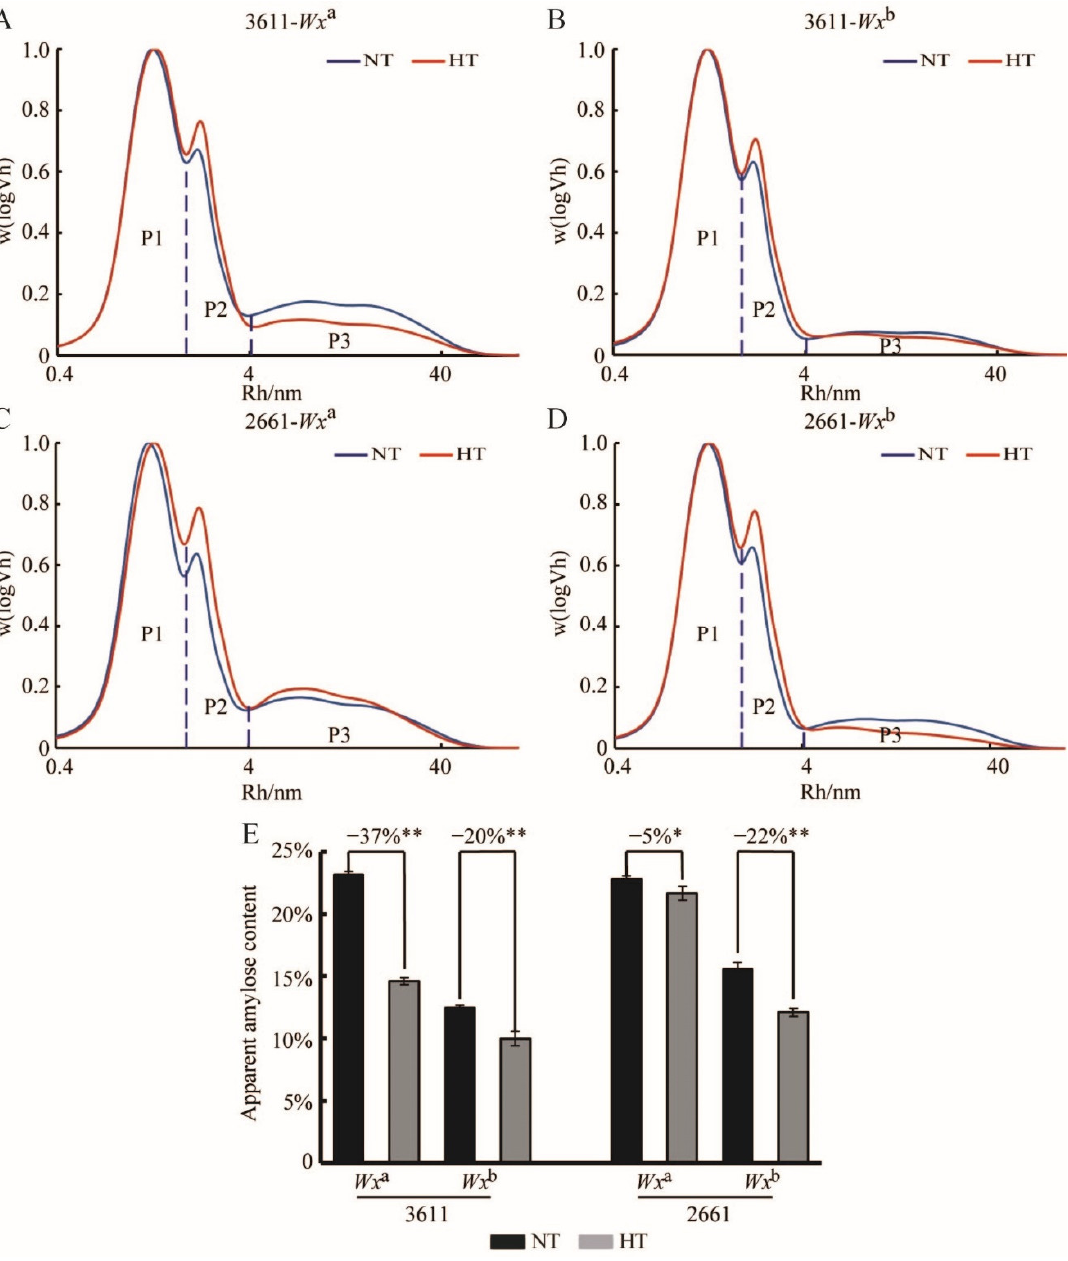
Figure 5. Starch SEC analysis of Wx NILs with 3611 ( A , B ) and 2661 ( C , D ) genetic backgrounds under different temperature conditions. P1, P2, and P3 represent the peaks of grade 2 amylopectin, grade 1 amylopectin, and amylose, respectively. P1 is composed of A chains and short B chains of external starch, and P2 is composed of long B chains. ( E ) Apparent amylose content analysis of Wx NILs with 3611 and 2661 backgrounds. Double asterisks denote a highly significant difference using Student’s t -test ( p < 0.01). A single asterisk denotes a significant difference using Student’s t -test (0.01 < p <